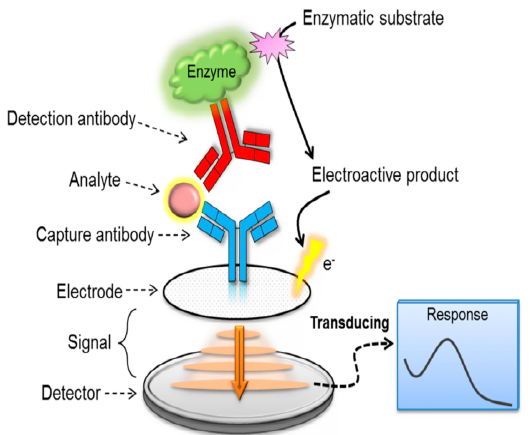
Figure 1. Electrochemical immunosensor basic analytical principle. Reproduced from MDPI [47].